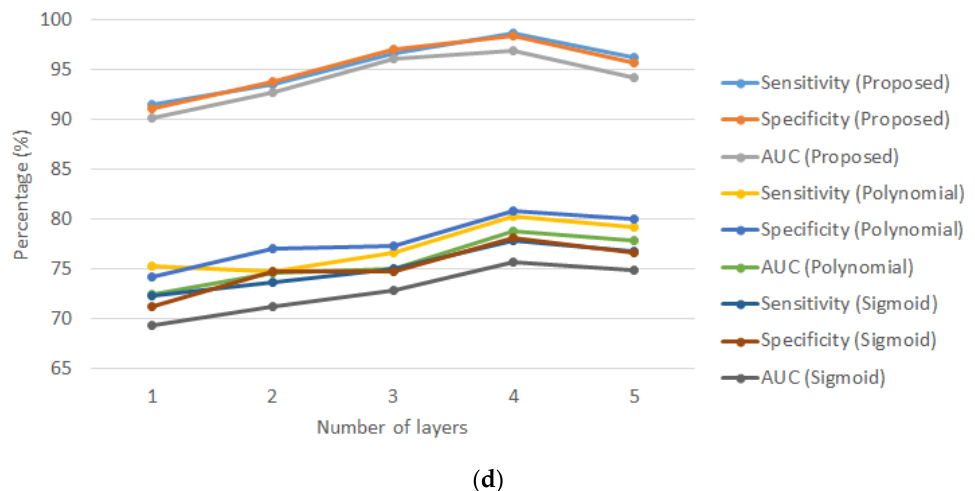
Figure 8. Average sensitivity, specificity and AUC of the proposed algorithm using multiple kernel learning (MKL) and typical single kernel versus number of layers under 10-fold cross-validation: ( a ) the MKL approach versus linear and radial basis function (RBF) kernels for driver drowsiness recognition; ( b ) the MKL approach versus polynomial and sigmoid kernels for driver drowsiness recognition; ( c ) the MKL approach versus linear and RBF kernels for driver stress recognition and ( d ) the MKL approach versus polynomial and sigmoid kernels for driver stress recognition.